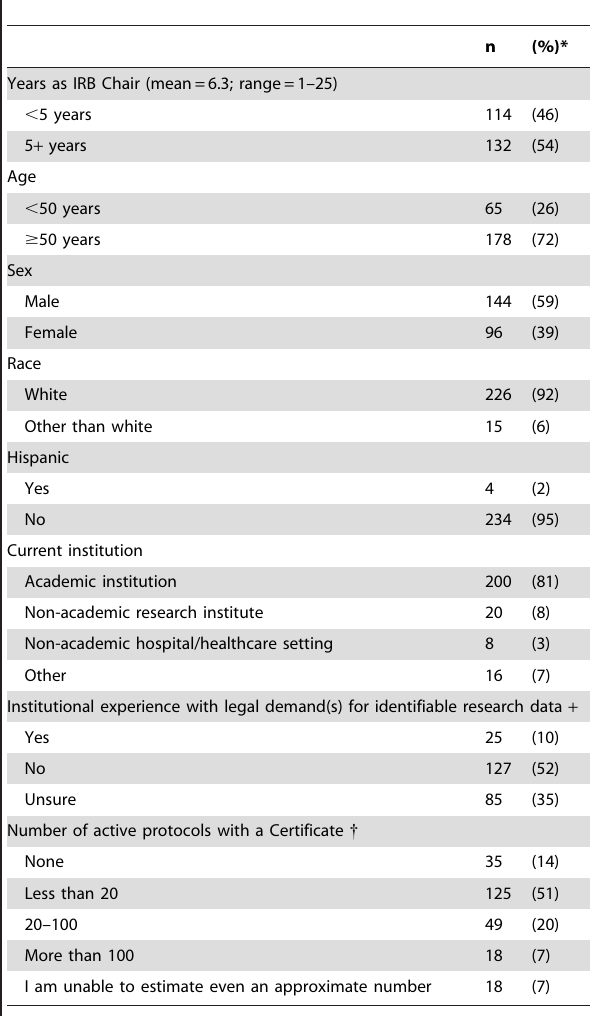
Table 1. Survey respondent characteristics